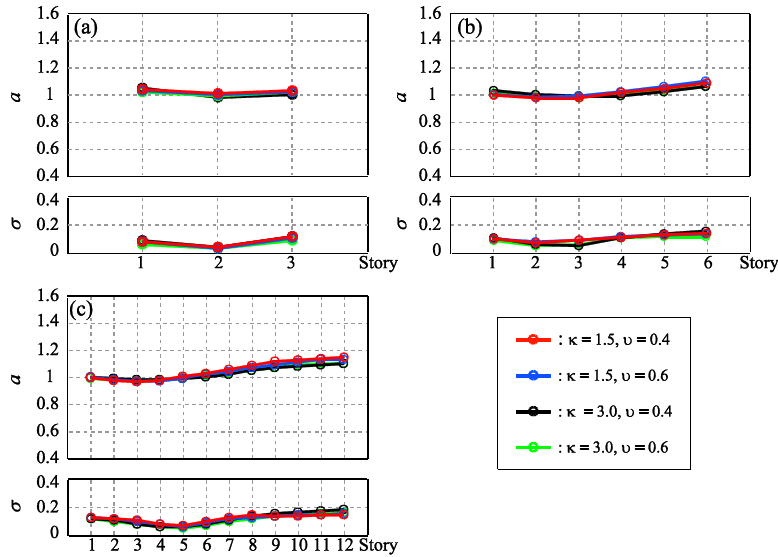
Figure 8. Bias ( a ) and dispersion ( σ ) of the simplified method: ( a ) for a three-story frame with dampers; ( b ) for a six-story frame with dampers; and ( c ) for a twelve-story frame with dampers.